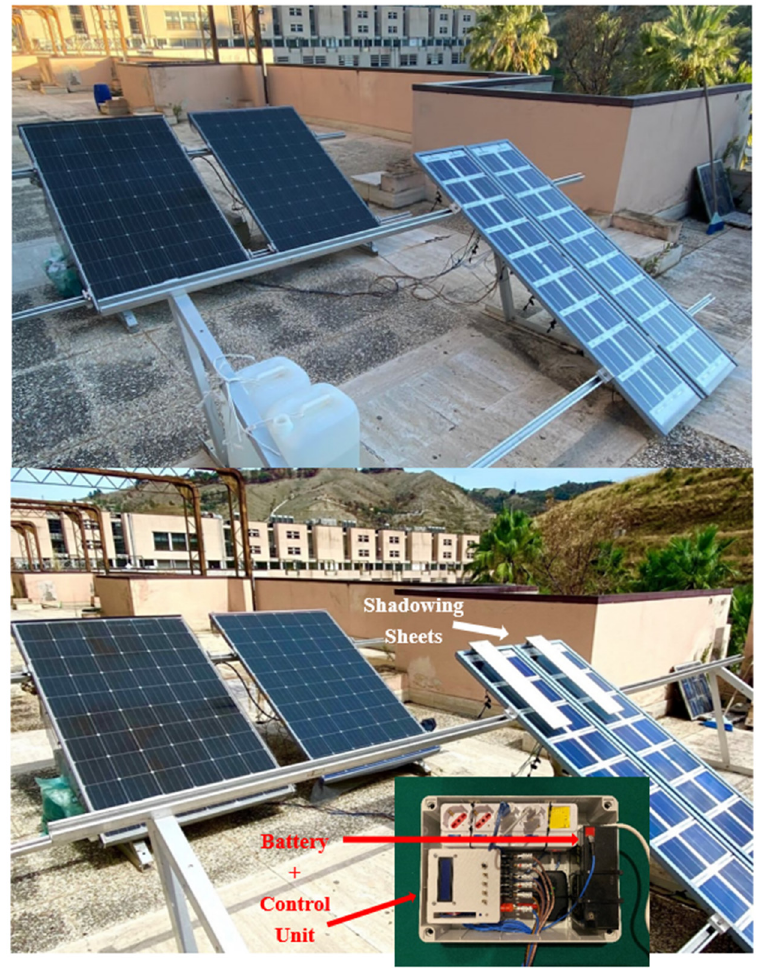
Figure 3. Some pictures describing the prototypal PV generator together with the BCU.